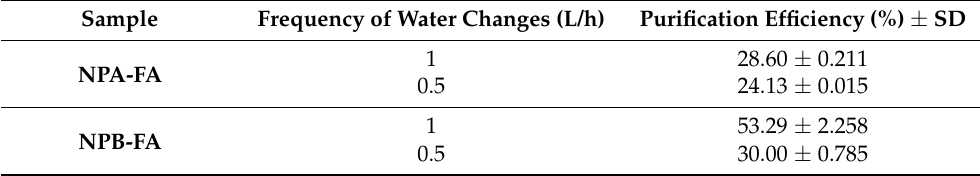
Table 2. Purification efficiency (%) of NPA-FA and NPB-FA referred to the purification processes using the dialysis method performed with frequency of water exchanges of 0.5 and 1 L/h.